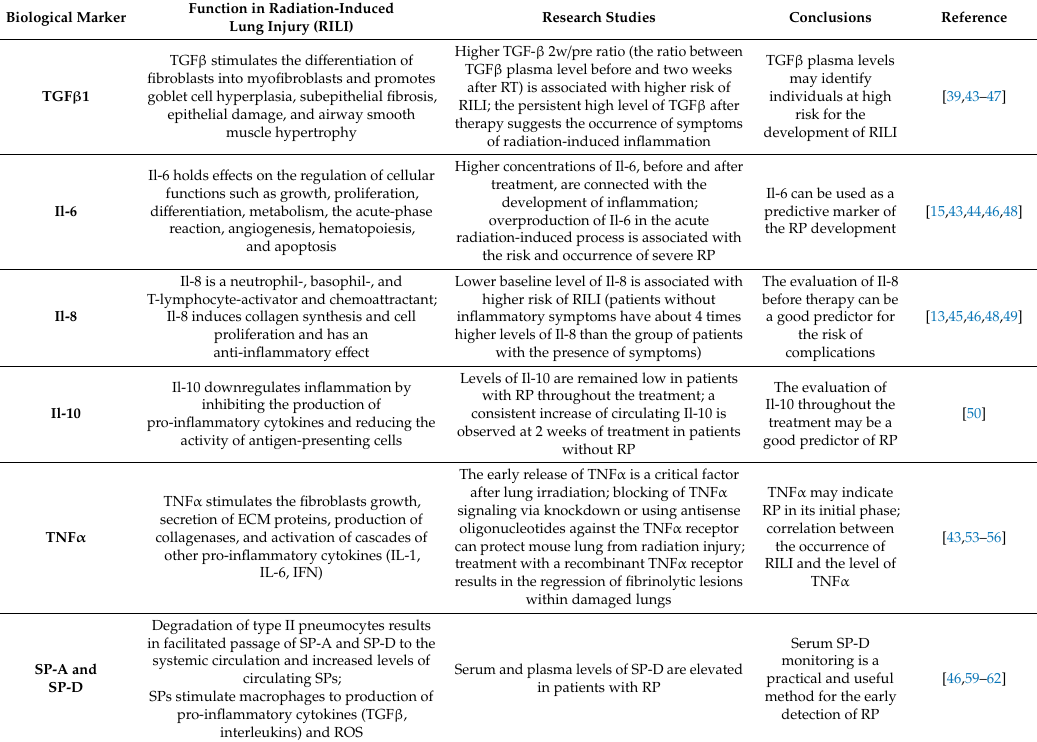
Table 2. Featured biological markers, their functions and usage in monitoring of